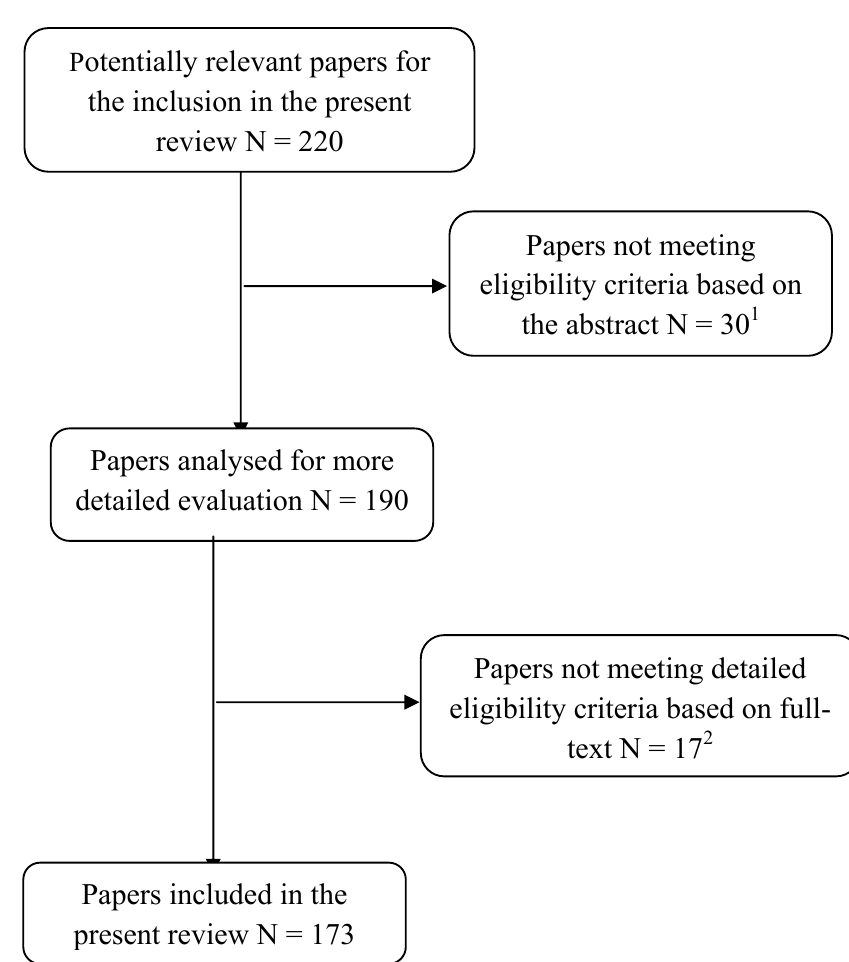
Figure 1. The search strategy for inclusion of studies in the current